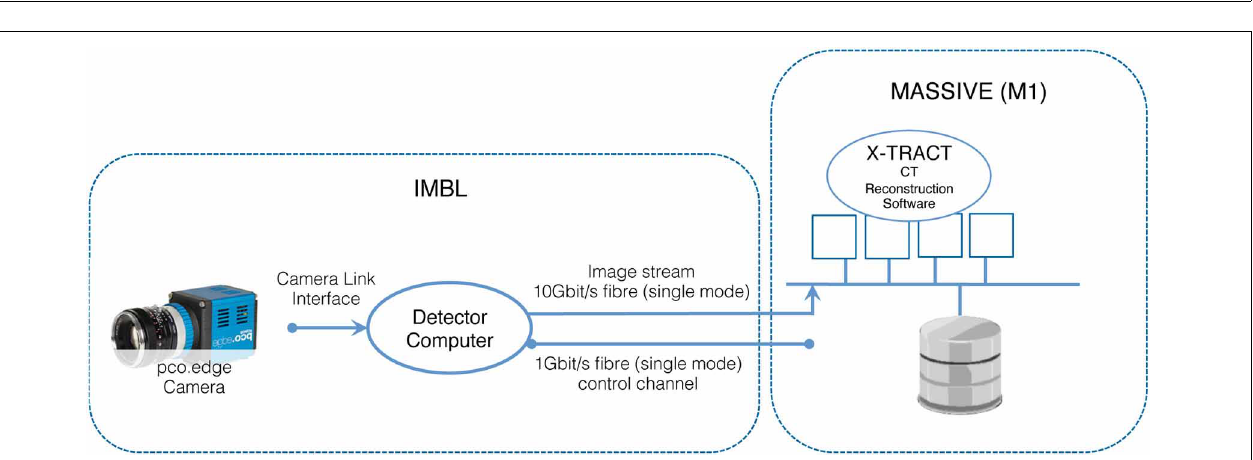
FIGURE 3 | Schematic of the neuroscience image data flow from Monash Biomedical Imaging and the computational processing performed on M2.